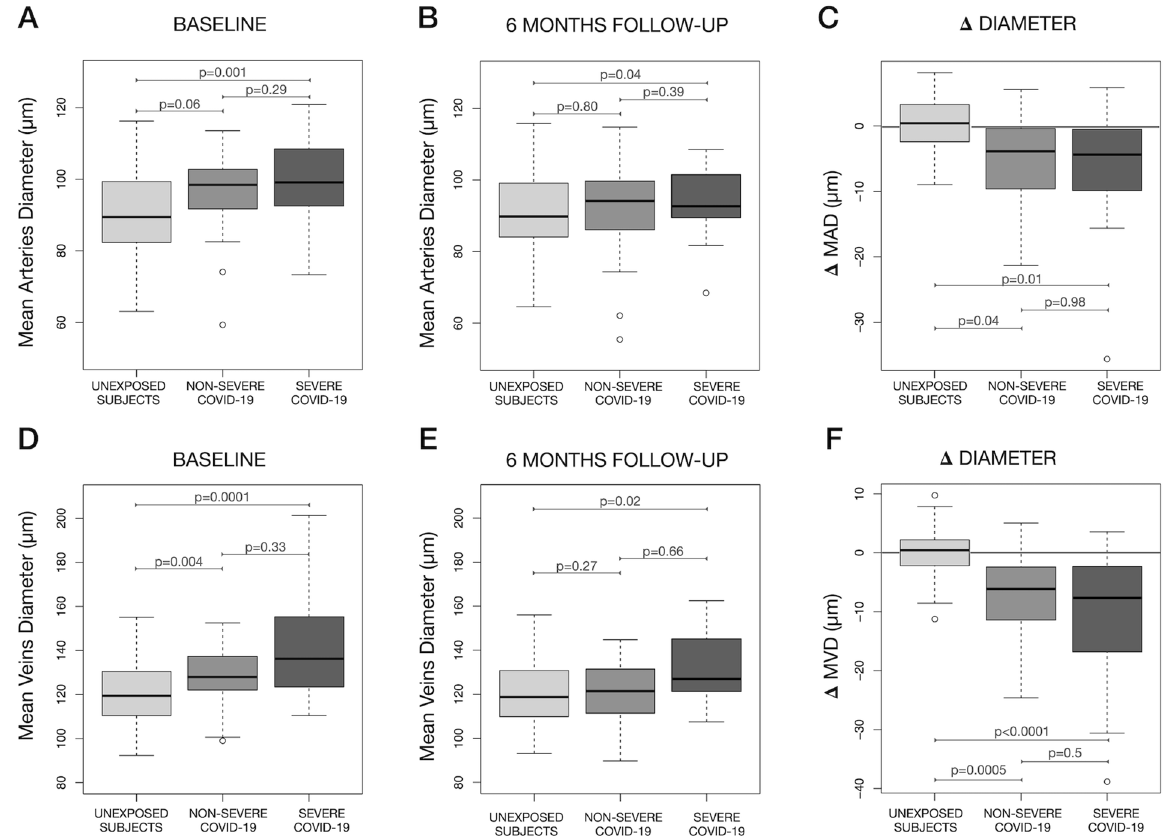
Figure 3. Comparisons in mean arteries diameter (MAD), mean veins diameter (MVD) at baseline and 6 months later and difference from baseline to follow-up (Δ Diameter) between severe COVID-19 patients, non-severe COVID-19 and subjects unexposed to the SARS-CoV-2 virus. At baseline MAD was higher in COVID-19 patients with a significant difference between severe COVID-19 and subjects unexposed to the virus ( A ). Six months later ( B ) MAD had reduced in both non-severe and severe COVID-19 patients but the arteries remained significantly thicker in severe COVID-19 compared to unexposed subjects. The reduction (Δ Diameter) was significantly higher in both severe and non-severe patients compared to controls. However the amount of change did not vary between severe and non-severe patients ( C ). At baseline MVD was significantly higher in both severe and non-severe patients compared to unexposed subjects ( D ). Six months later the difference remained significant only for severe cases (E). Similarly to what happened with MAD, the reduction